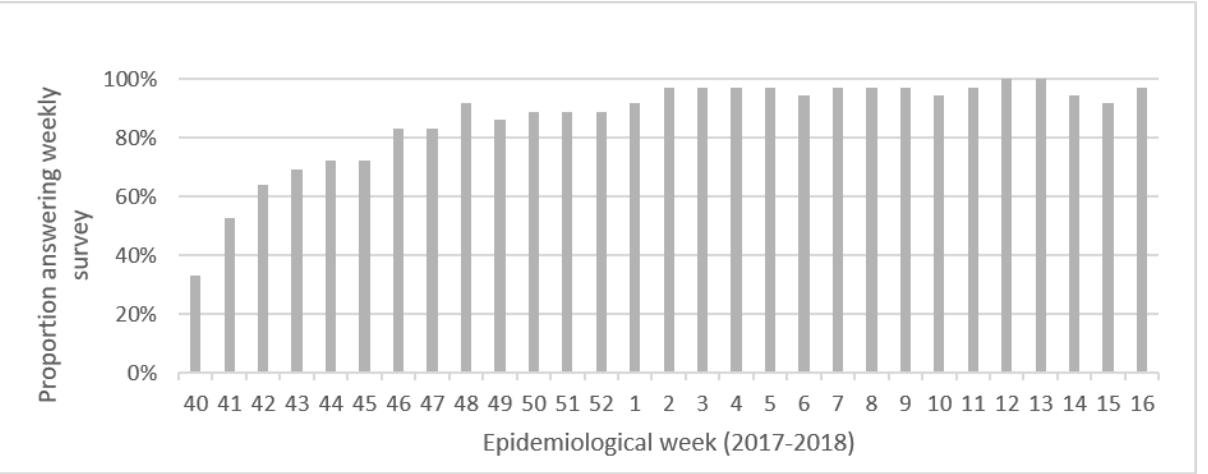
Figure 4. Proportions of participants answering to weekly online survey